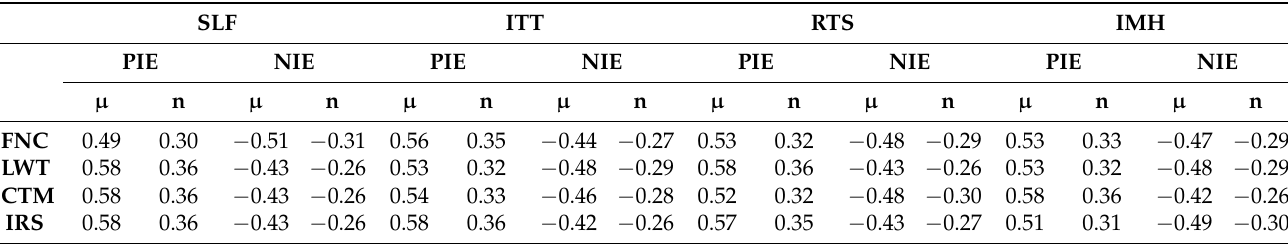
Table A14. Average values for the competencies.